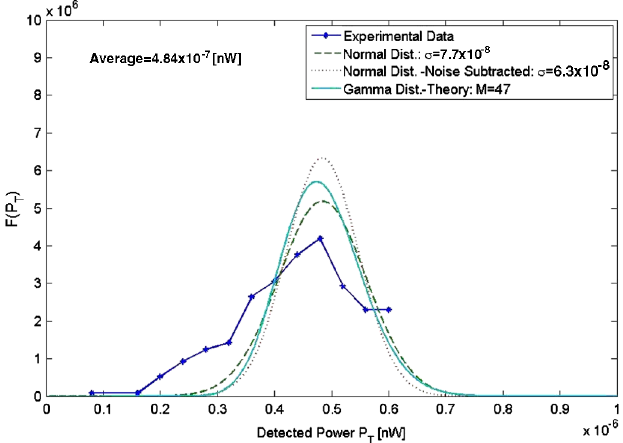
FIG. 5. (Color) Comparison of the experimental data to a Gamma distribution with the theoretical value M ¼ 47 , the Gaussian approximation for the latter, with standard deviation 77 nW and the normal distribution with standard deviation 63 nW